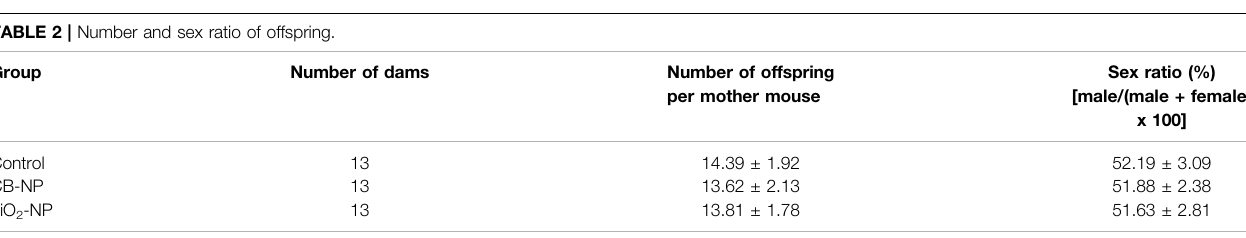
TABLE 2 | Number and sex ratio of offspring. Group Number of dams